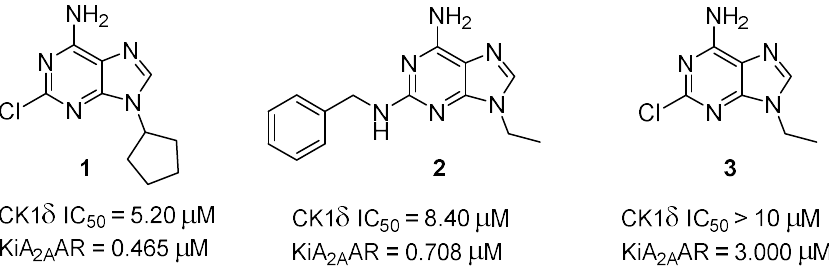
Figure 2. Structures and IC 50 values of adenosine receptor antagonists endowed with CK1δ inhibitory activity.